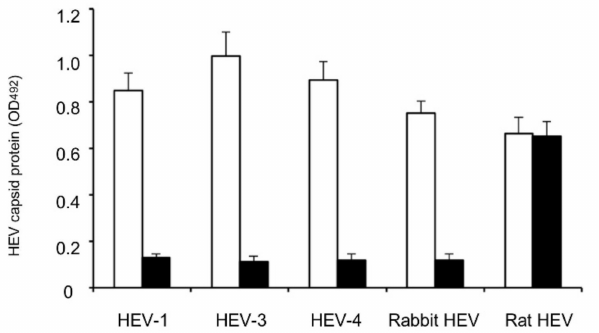
Figure 4. Neutralizing activity of anti-RsVLPs antibody. The neutralizing activity of anti-RsVLPs